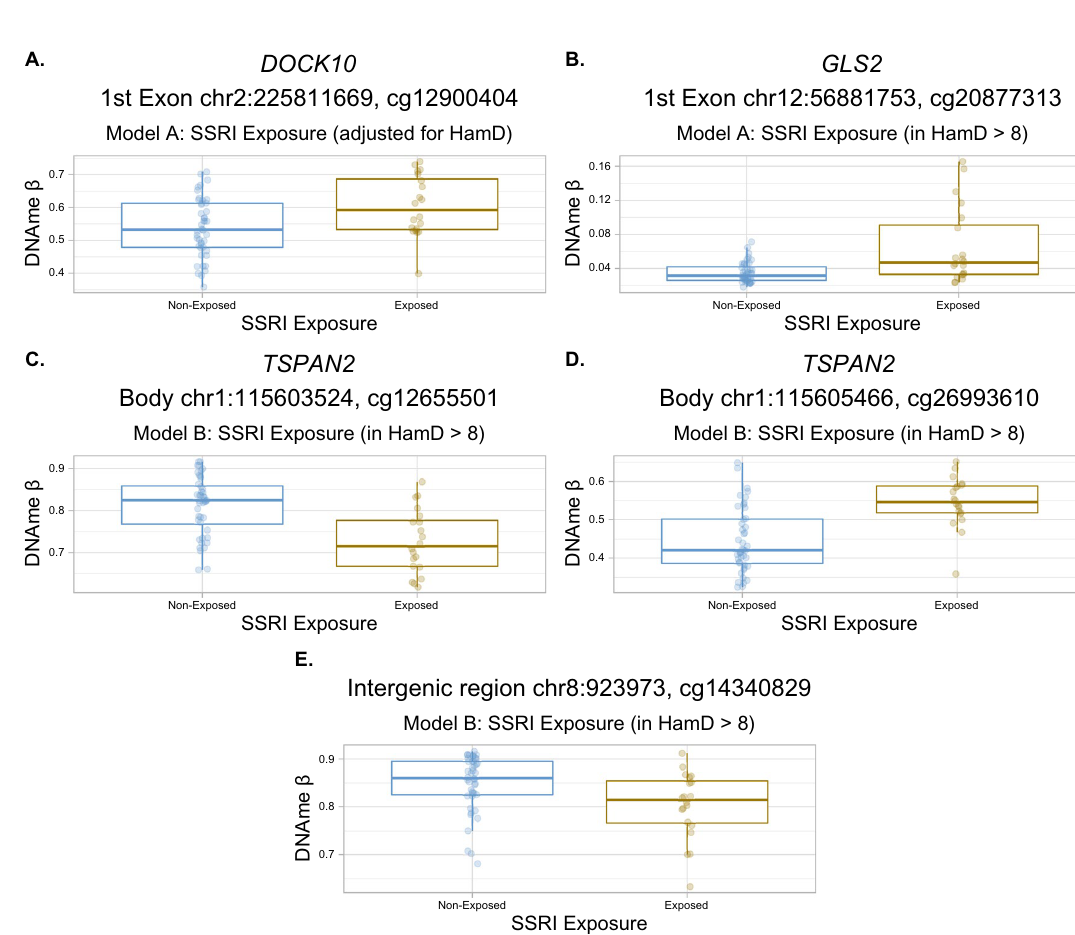
Figure 3. Boxplots of differentially methylated CpGs by SSRI exposure. For all plots, points are colored by SSRI exposure (blue = SSRI non-exposed, dark yellow = SSRI-exposed), and boxplots indicate mean DNAme β value ± one standard deviation. ( A ) Boxplot of cg12900404, identified in the SSRI model, model A. ( B ) Boxplot of cg20877313, identified in the SSRI model, model A. ( C ) Boxplot of cg12655501, identified in the SSRIs in maternal depression model, model B. ( D ) Boxplot of cg26993610, identified in the SSRIs in maternal depression model, model B. ( E ) Boxplot of cg14340829, identified in the SSRIs in maternal depression model, model